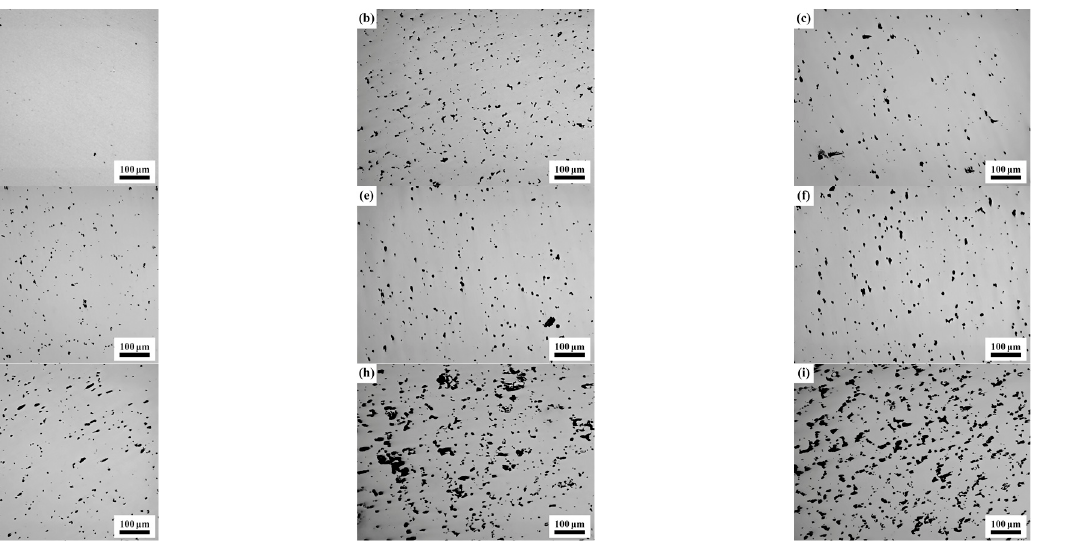
Figure 6. OM images of the Ni2# superalloy after solution heat treatment, ( a ) 1150 ◦ C × 0.5 h, ( b ) 1150 ◦ C × 2 h, ( c ) 1150 ◦ C × 4 h, ( d ) 1175 ◦ C × 0.5 h, ( e ) 1175 ◦ C × 2 h, ( f ) 1175 ◦ C × 4 h, ( g ) 1200 ◦ C × 0.5 h, ( h ) 1200 ◦ C × 2 h, and ( i ) 1200 ◦ C × 4 h.